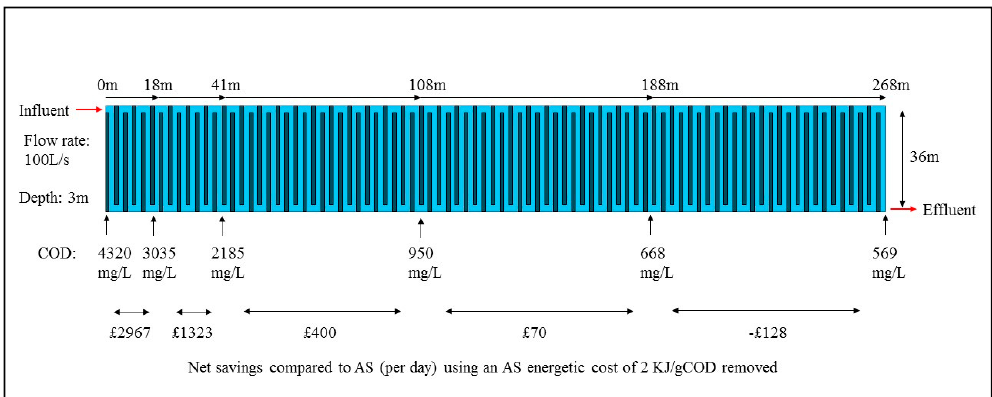
Figure 4. A theoretical tank design required for the actual flow rate found at Howdon Wastewater